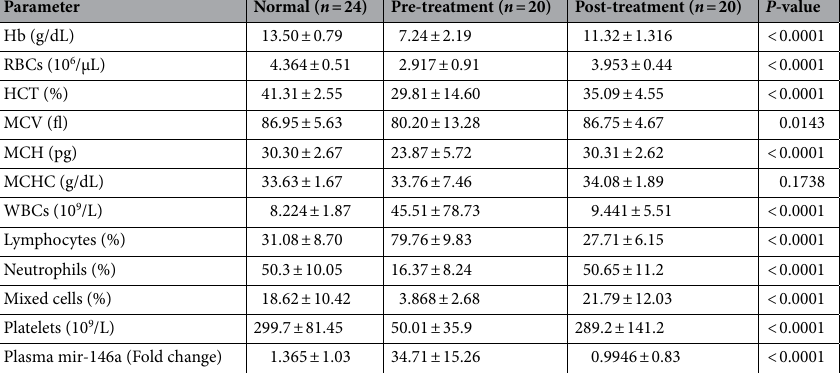
Table 2. Plasma levels of mir-146a and hematological parameters before and after treatment in ALL. The values are mean ± SD (standard deviation). P -values are significant at < 0.05.